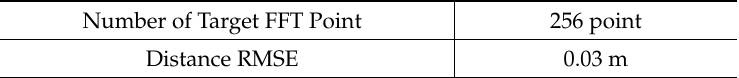
Table 4. DDC FMCW LiDAR system application